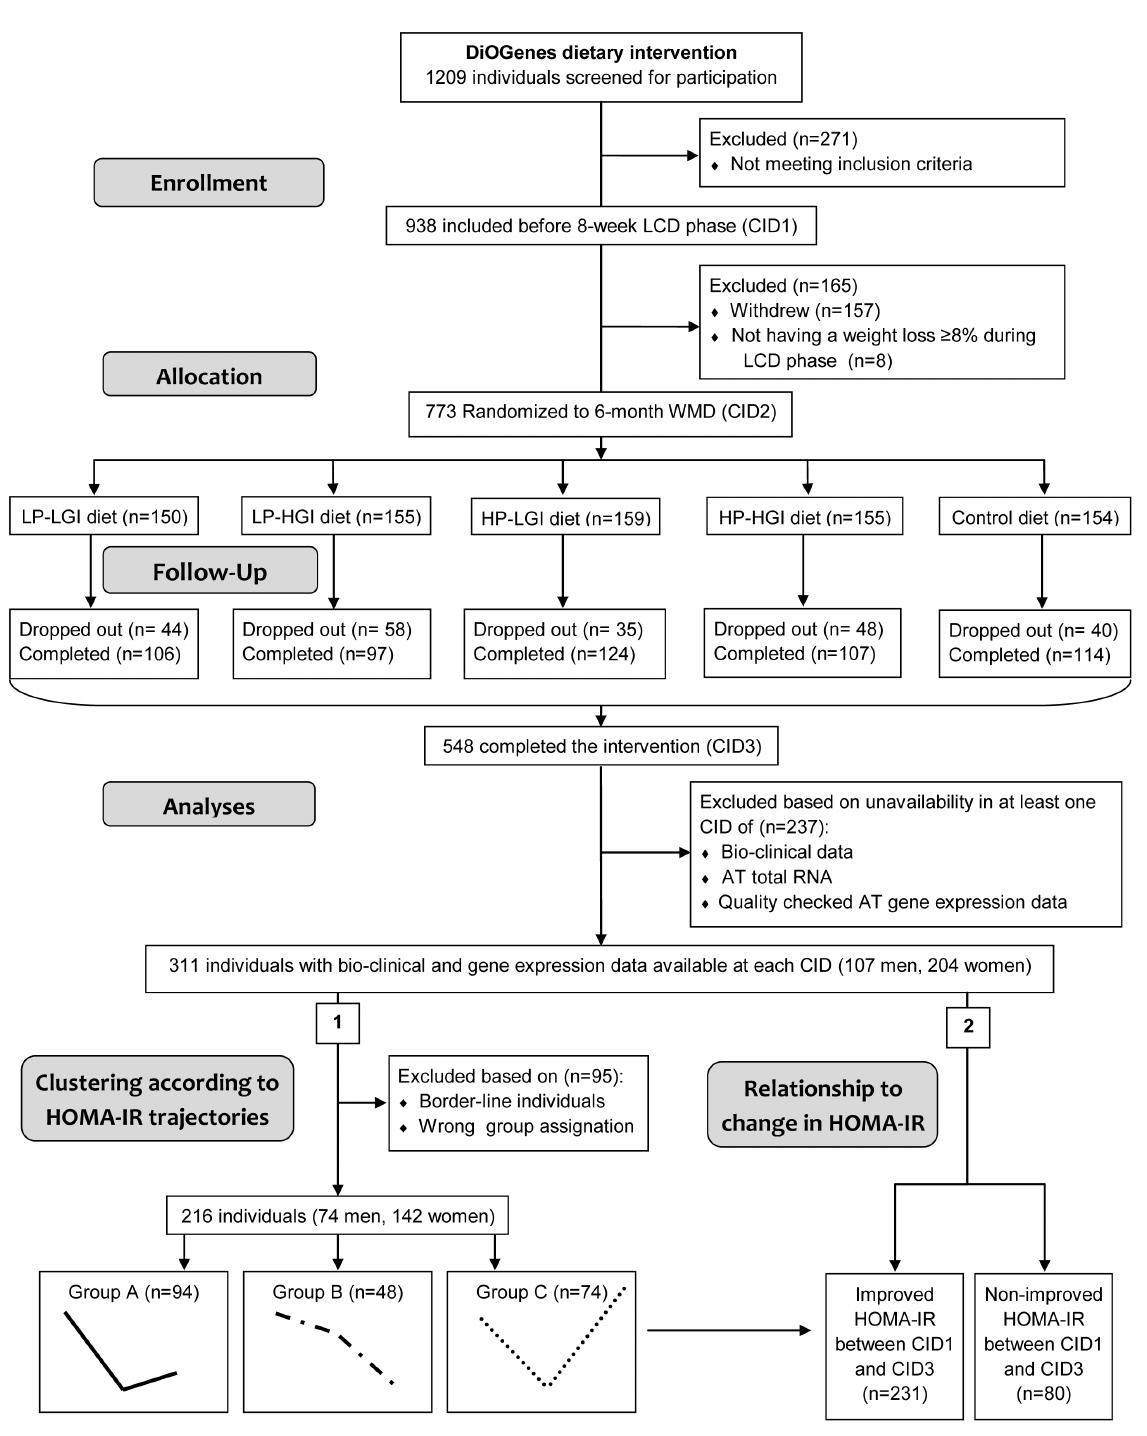
Figure 1. Flowchart for individuals’ selection from the DiOGenes cohort. Participants entering subsequent phases of the study as well as dropouts are indicated in total. AT, adipose tissue; CID, clinical investigation day; HGI, high glycemic index; HOMA-IR, Individual Homeostasis Model Assessment of Insulin Resistance; HP, high protein; LCD, low calorie diet; LGI, low glycemic index; LP, low protein; WMD, weight maintenance diet.